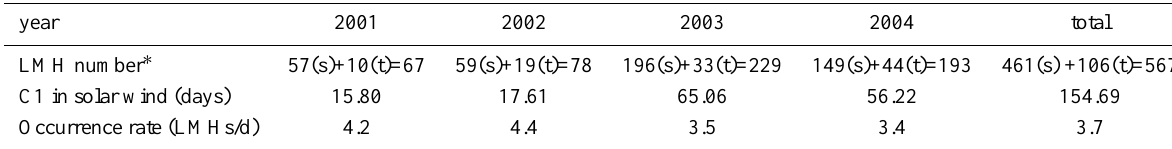
Table 1. LMHs in the solar wind found by Cluster C1 from 2001 to